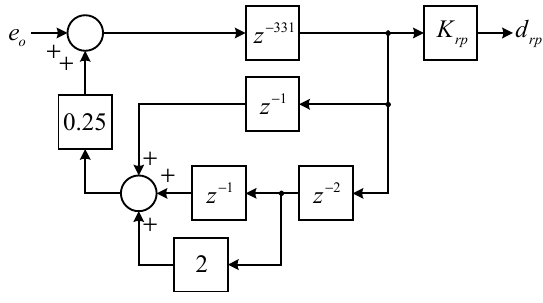
Figure 11. The block diagram of the repetitive controller.